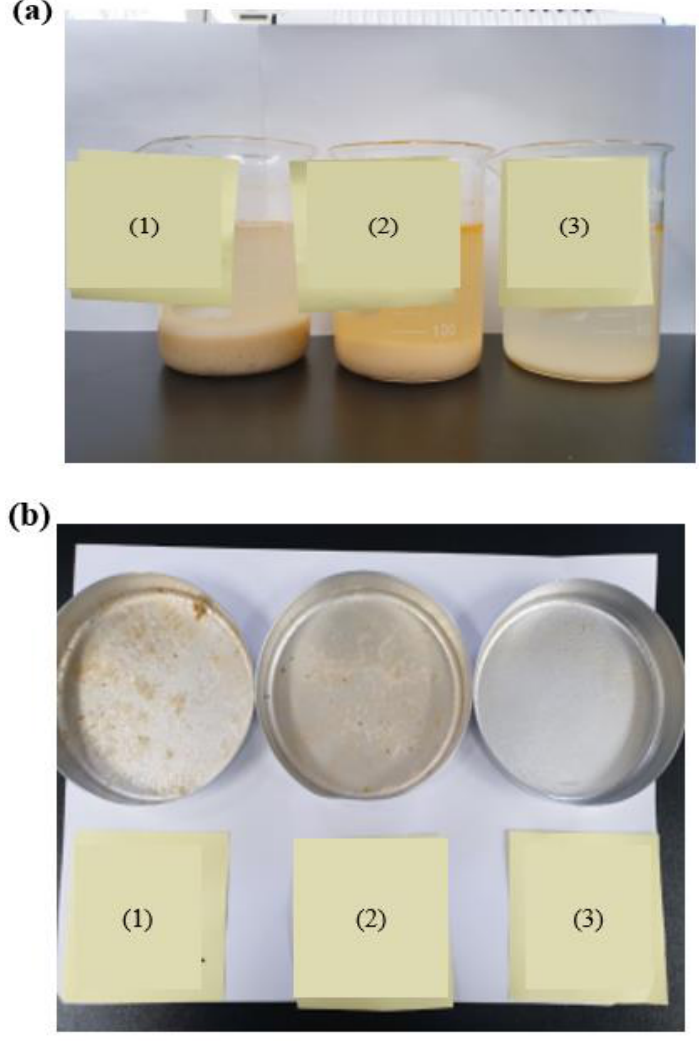
Figure 3. Sedimentation photograph of wastewater by FW treatment method ( a ) and dried photo- graph ( b ). (1) is WD, (2) is GR, and (3) is wastewater discharged from MLF